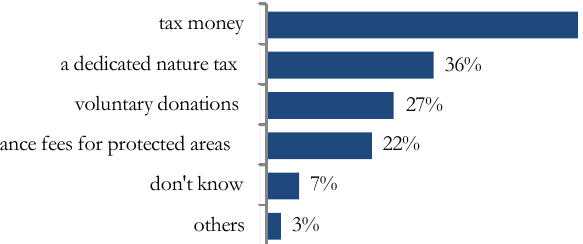
Figure 9: Responsibility for funding nature conservation in the view of visitors surveyed in the Eastern Ore Mountains (n=308)